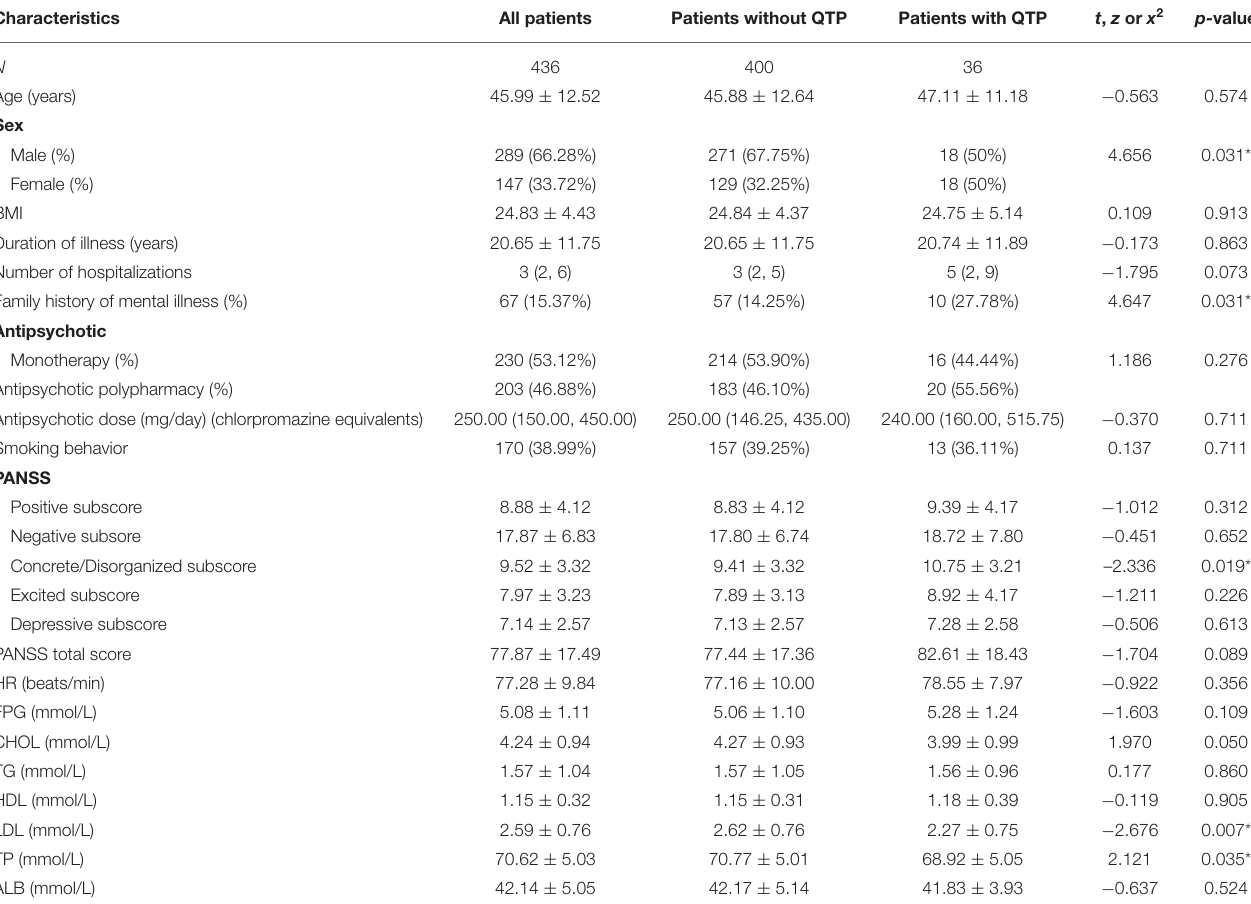
TABLE 2 | Characteristics of schizophrenia patients with or without QTc prolongation. Characteristics All patients Patients without QTP Patients with